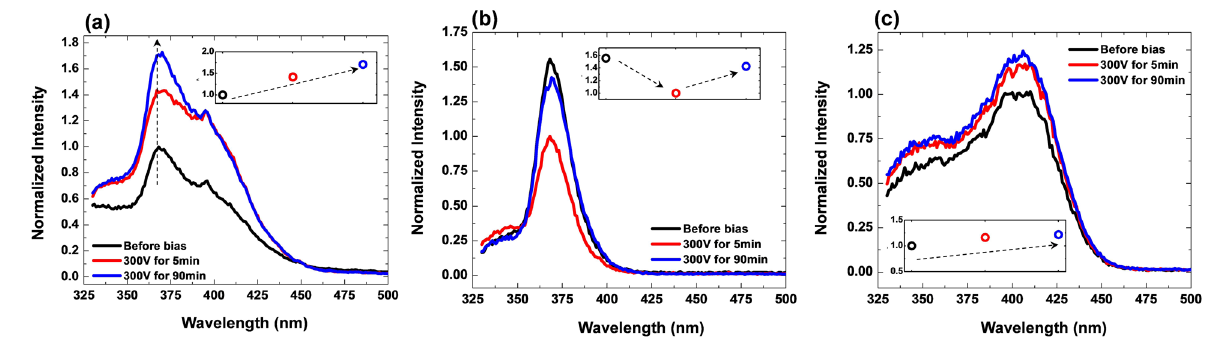
Fig. 10 Bias-dependent excitation spectra. Excitation spectra of ( a ) CABC, ( b ) CAIC and, ( c ) Bi 0.10 In 0.90 compound measured at an applied voltage of 300 V. Here, excitation spectra monitored at an emission wavelength of 575 nm.